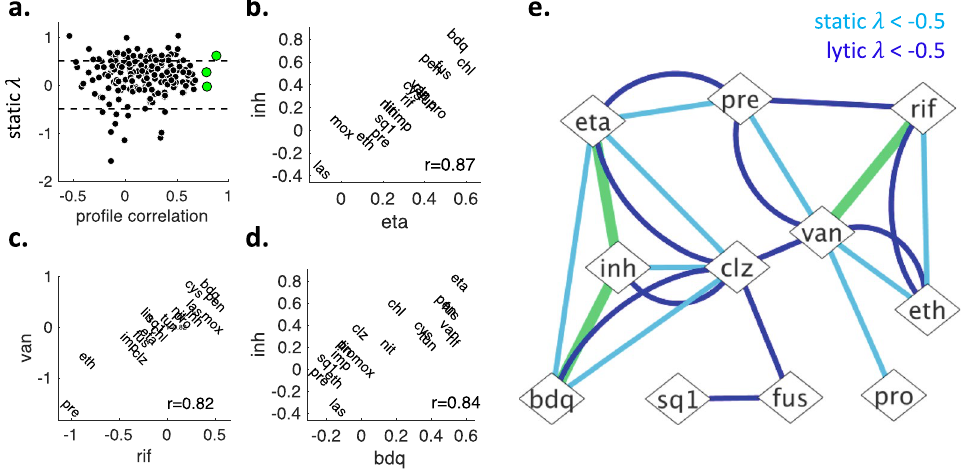
Figure 3. Finding drug pairs with similar drug interaction profiles and snapshot summary of pairwise static- lytic synergies and profile-similarity. (a ) X-axis shows the static λ score profile correlations for drug pairs. Profile correlation is high for two drugs with similar drug interaction profiles. Y-axis shows the static λ for two drugs, which is negative, zero, or positive for synergistic, additive and antagonistic drug pairs, respectively. Each black circle indicates one pairwise drug combination. Three red circles show three drug pairs whose profiles were significantly correlated after Bonferroni correction (p < 2.6 × 10 − 4 ). Profile similarity of these pairs are visualized in ( b–d ), with the corresponding Spearman correlation scores. We define these pairs as “similar drugs”. ( e ) After the analysis of 190 pairs involving 20 drugs, we found 11 pairs with static synergy ( static λ < − 0.5, light blue edges), 9 pairs with lytic synergy ( lytic λ < − 0.5, dark blue edges) and three similar drug pairs (green